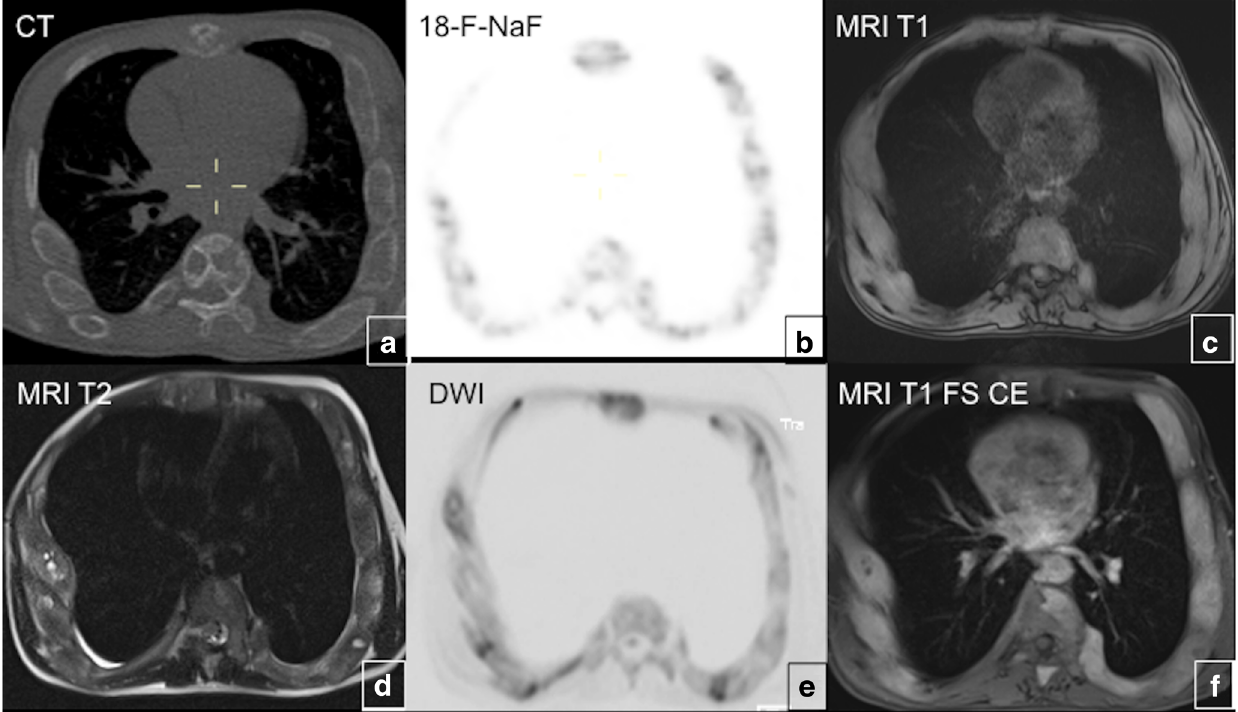
Fig. 11 Multimodality imaging in polyostotic fibrous dysplasia (FD). a , b PET/CT with 18-F-NaF demonstrates multiple lucent FD lesions seen on CT with corresponding areas of mild radiotracer uptake on PET. c – f Lesions demonstrate intermediate T1 signal intensity on MRI ( c ),